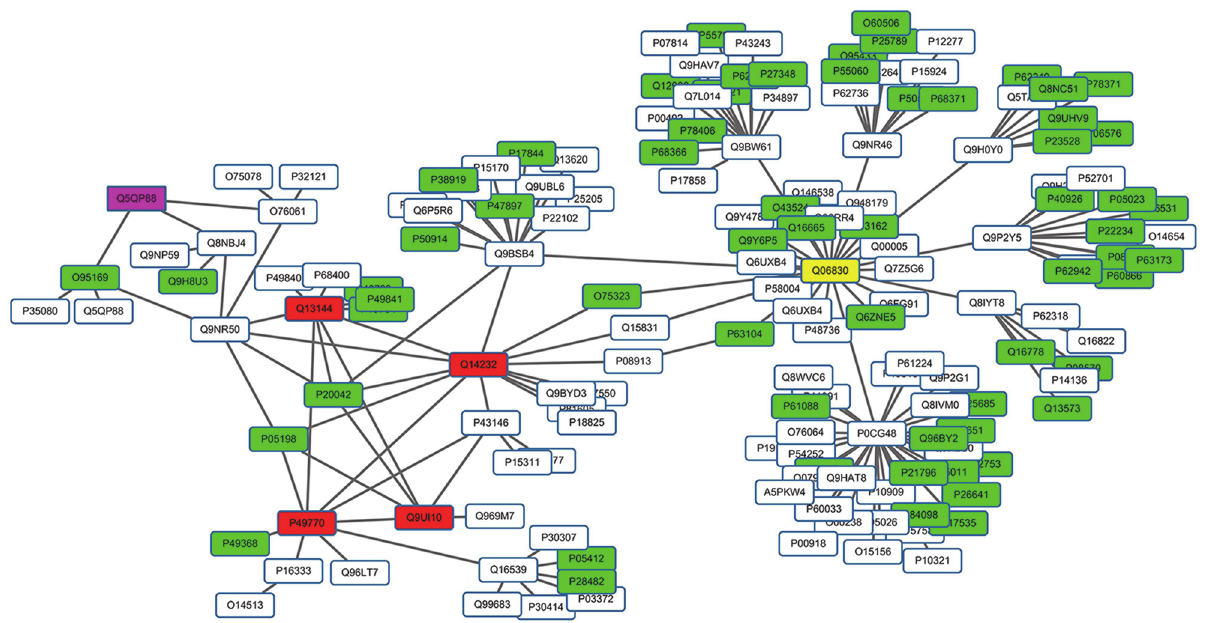
Fig 5. Leukoencephalopathy with Vanishing White Matter Protein-Protein Interaction